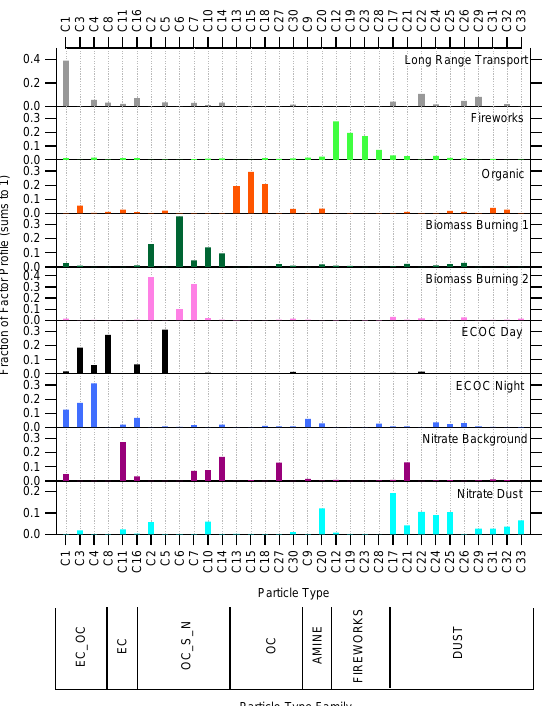
Fig. 3. Factor particle-type profiles of the nine PMF factors. To fa- cilitate discussion of the particle-type apportionment,